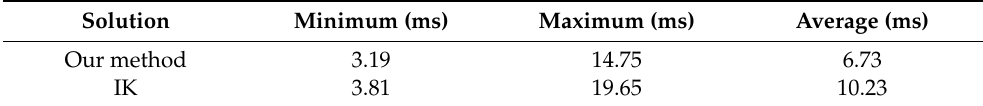
Table 5. Performance evaluation in a standalone VR application.